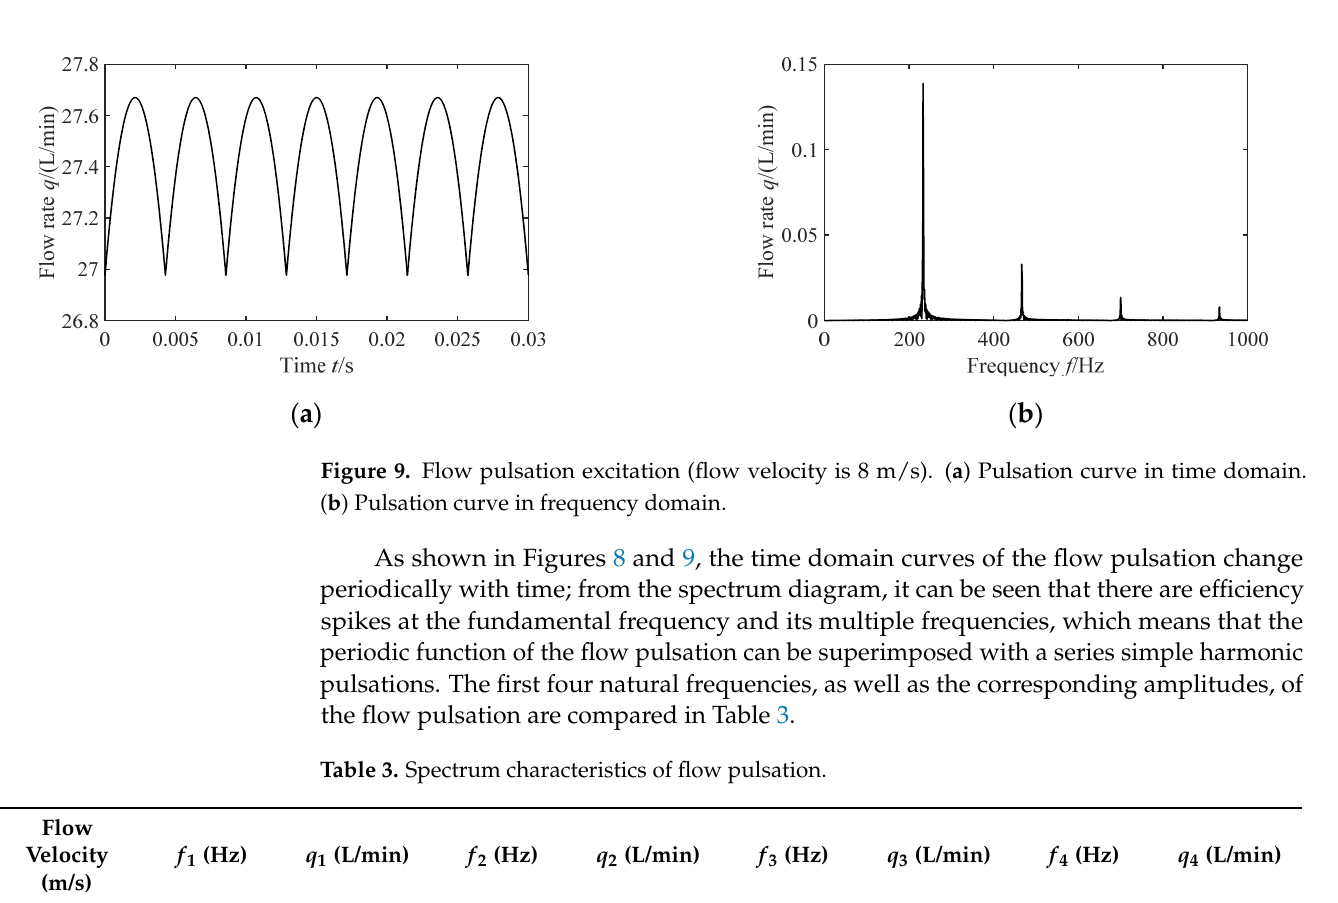
Figure 8. Flow pulsation excitation (flow velocity is 2 m/s). ( a ) Pulsation curve in time domain. ( b ) Pulsation curve in frequency domain.